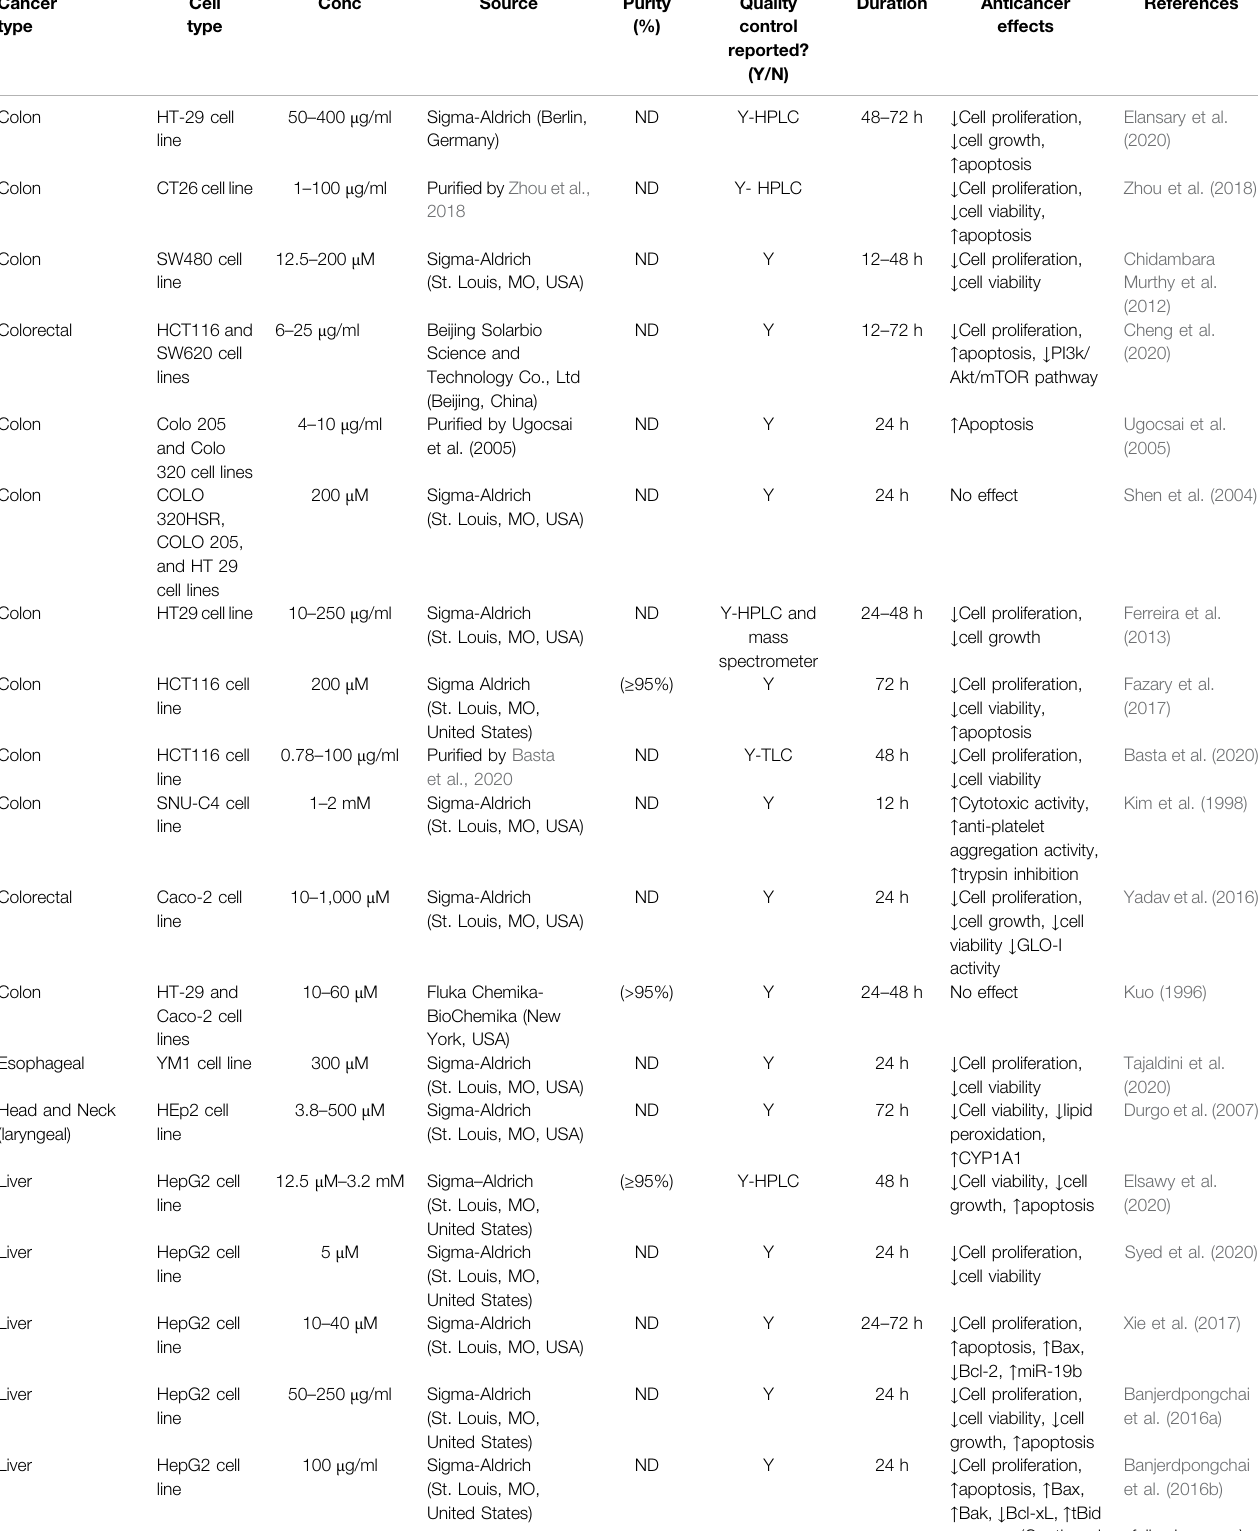
TABLE 3 | ( Continued ) Potential anticancer effects and related mechanisms of action of naringin based on in vitro